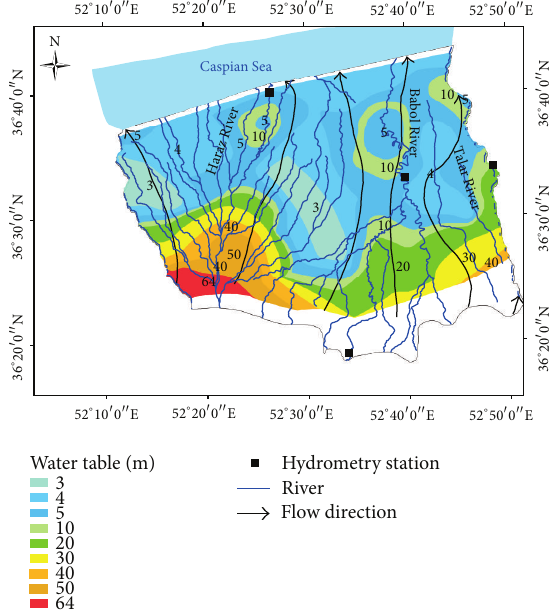
Figure 2: Schematic map of groundwater table in the study area. (Figure 2). The hydraulic gradient varies from 10 per thou- sand in the southern area to 0.5 per thousand in the coastal plain of the Caspian Sea [26]. There are around 61,496 shallow and 6,634 deep wells on the Amol-Babol Plain. The water abstraction from the plain aquifer was about 390 million m 3 for agricultural activities and around 44 million m 3 for drink- ing purposes, during the 2008 to 2009 period [26]. The total abstraction of groundwater was 507 million m 3 through the wells, springs, and quants, of which 342 million m 3 (around 94%) was discharged from wells